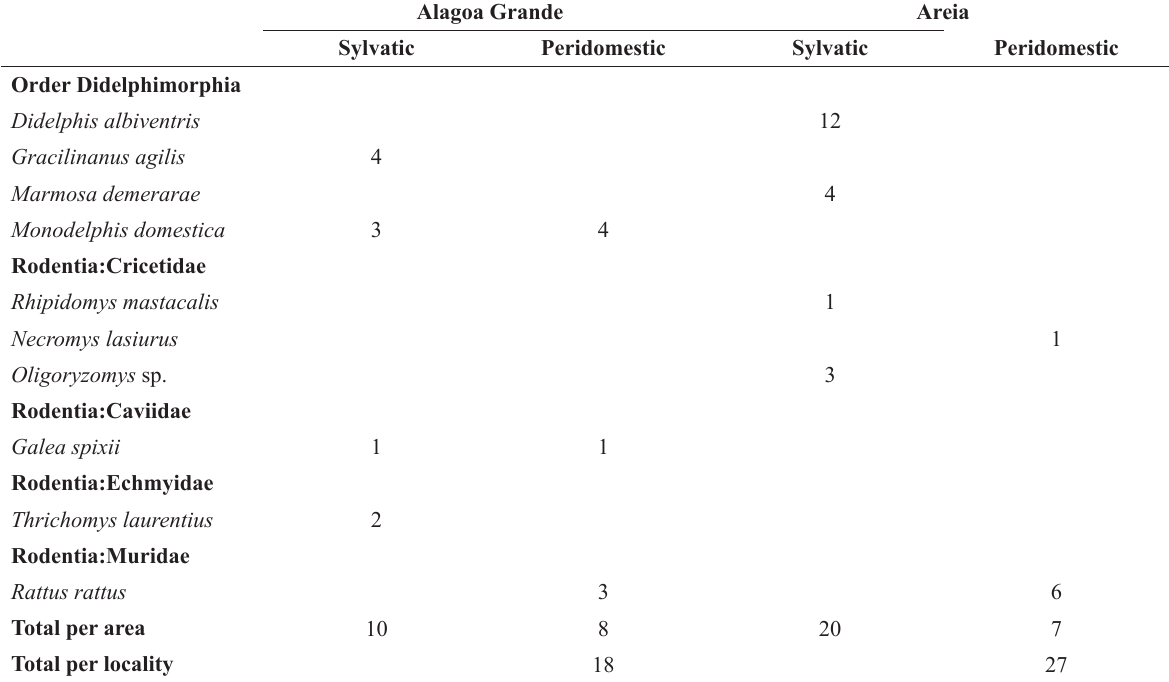
Specimens captured during the field survey, discriminated by locality and ecotope. Alagoa Grande Areia Sylvatic Peridomestic Sylvatic